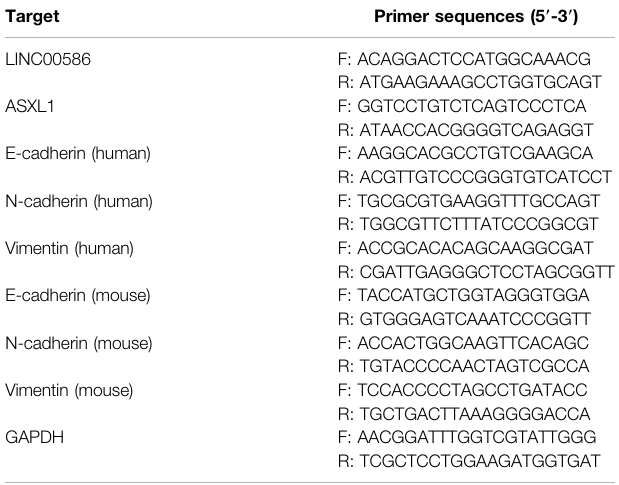
TABLE 1 | Primer sequences used for